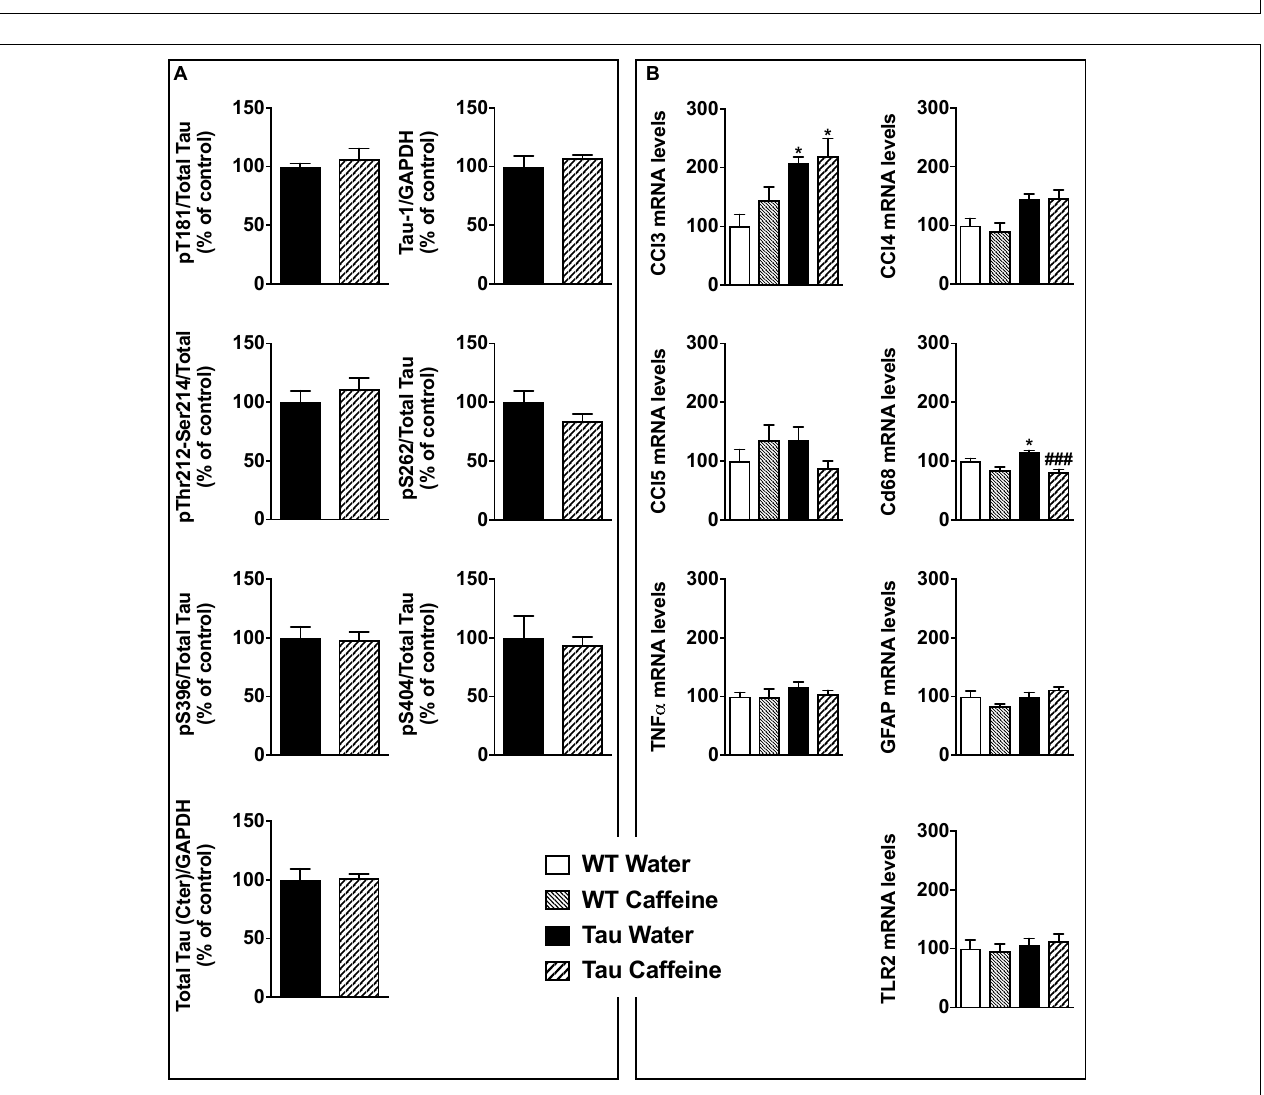
FIGURE 5 | Investigation of early-life exposure to caffeine on hippocampal Tau phosphorylation and associated neuroinflammatory markers. (A) Western blot analysis of tau phosphorylation in water or caffeine exposed THY-Tau22 offsprings using antibodies targeting physiological (pThr181, Tau-1, pSer262, pSer396, pSer404) and pathologic (pThr212/Ser214) Tau epitopes. Quantifications were performed over total tau levels (Cter). Total tau levels were quantified versus GAPDH, used as loading control ( n = 7/group). (B) qPCR analysis of hippocampal neuroinflammatory markers associated with Tau pathology in the THY-Tau22 model ( n = 6–10 per